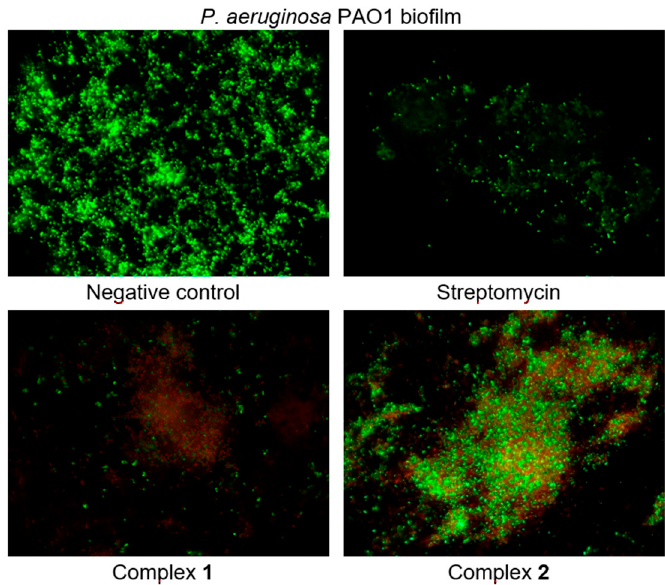
Figure 11. Epifluorescence microscopy images of P. aeruginosa PAO1 biofilm treated with 1 mM of ruthenium complexes. Biofilm was stained with nucleic acid stains using the FilmTracer™ LIVE/DEAD Biofilm Viability Kit (Invitrogen, Carlsbad, CA, USA; live cells are represented by the colour green; dead cells are represented by the colour red). The epifluorescence microscopy images were captured at 1000× magnification.